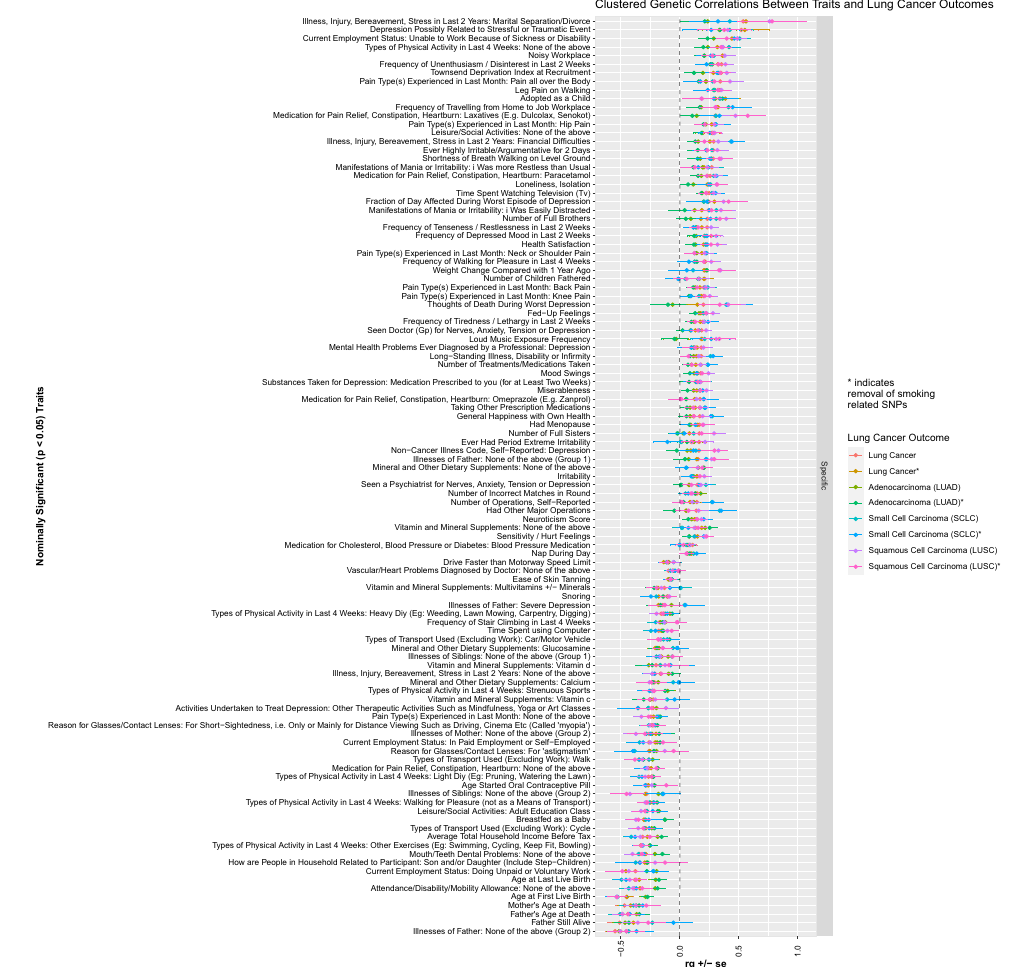
Figure 8. Overlapping forest plot of nominally significant trait associations with lung cancer outcomes clustered by specific